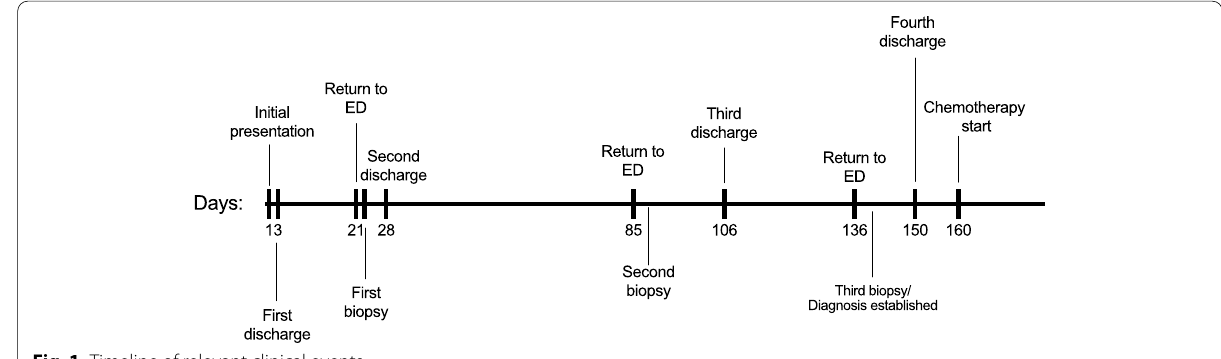
Fig. 1 Timeline of relevant clinical